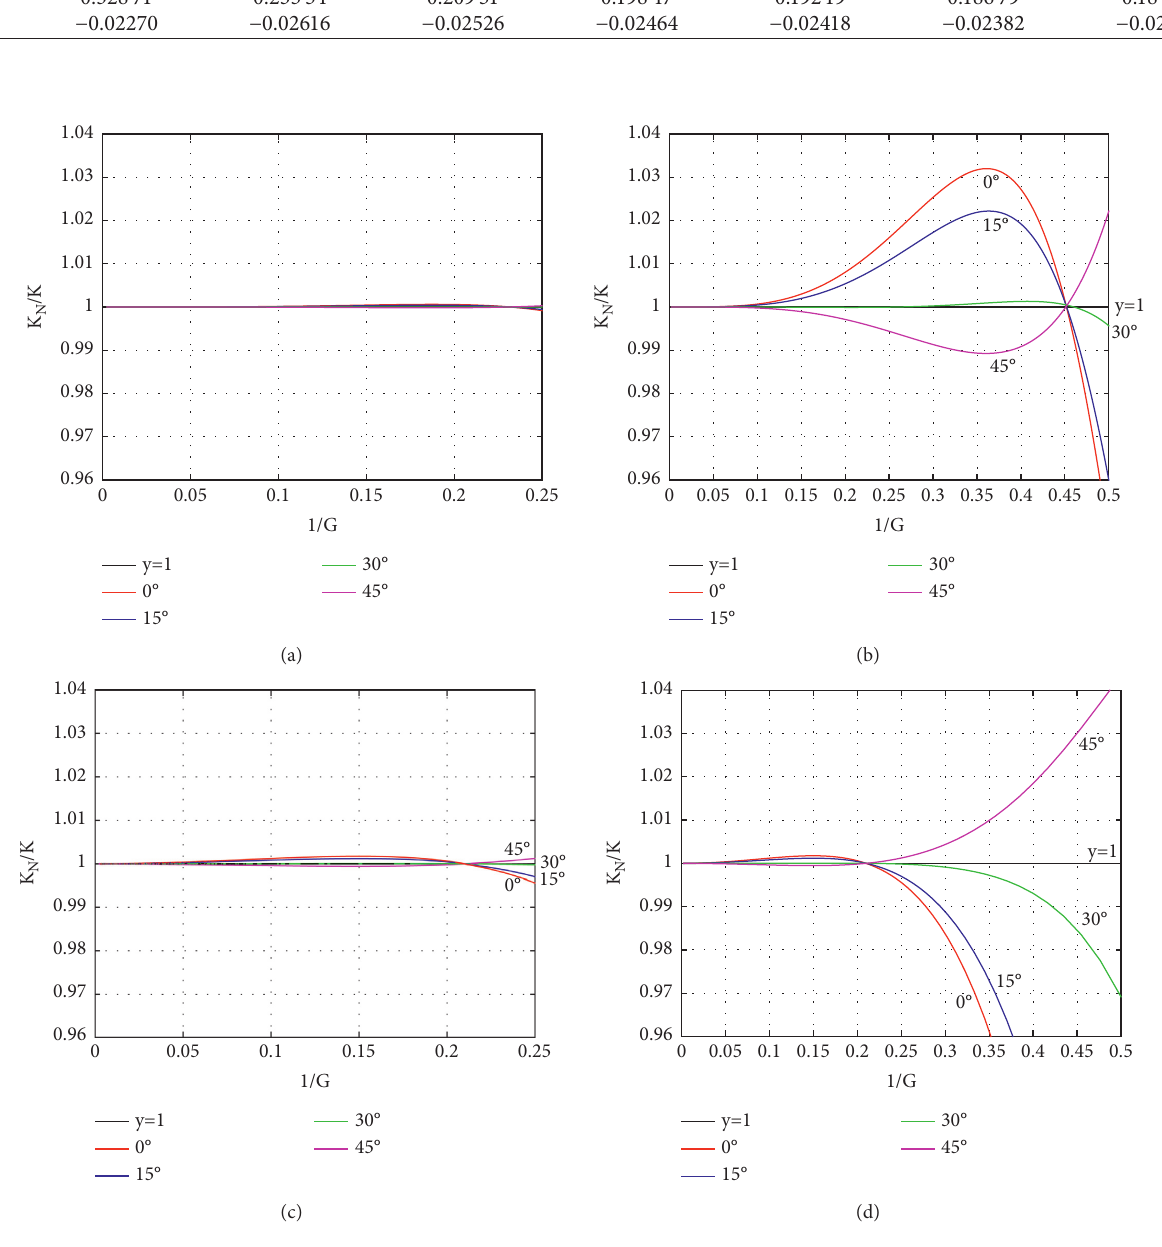
Figure 2: Normalized phase velocity curves. (a) The 21p scheme for G ∈ [ 4 , 400 ] . (b) The 21p scheme for G ∈ [ 2 , 400 ] . (c) The 9p scheme for G ∈ [ 4 , 400 ] . (d) The 9p scheme for G ∈ [ 2 , 400 ]